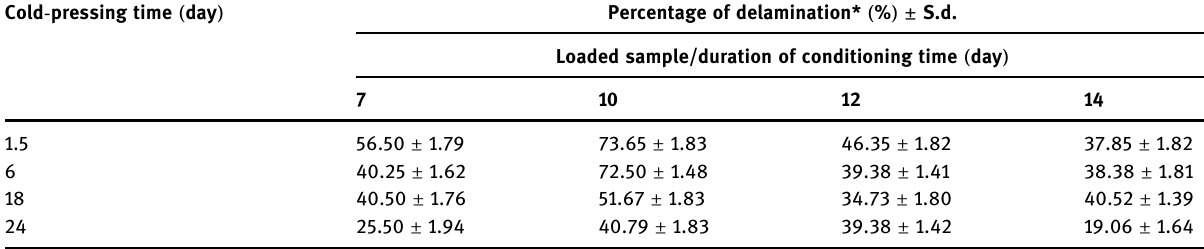
Cold - pressing time ( day ) Percentage of delamination* ( % ) ±